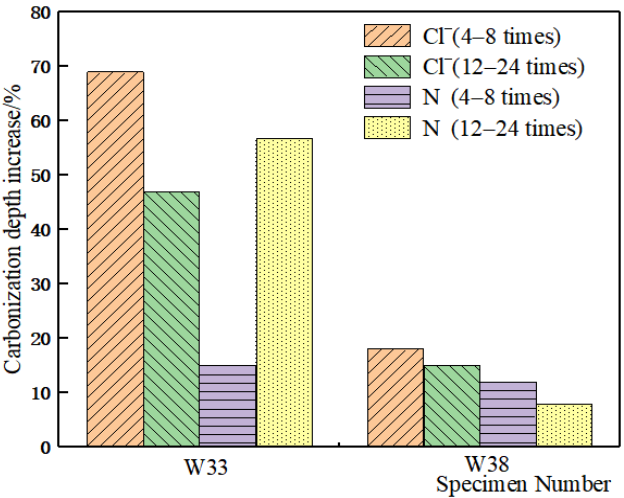
Figure 7. Concrete carbonation depth in different test conditions with different numbers of cycles: ( a ) W/C ratio of 0.33; ( b ) W/C ratio of 0.38.